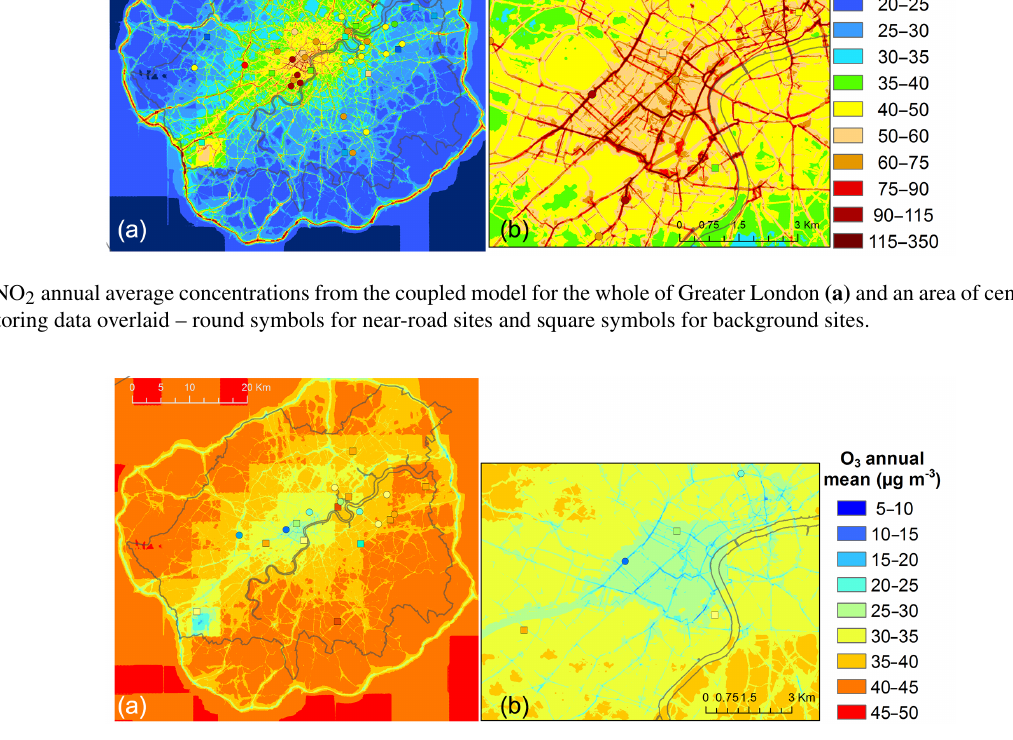
Figure 6. O 3 annual average concentration contours from the coupled model for the whole of Greater London (a) and an area of central London (b) , with monitoring data overlaid – round symbols for near-road sites and square symbols for background